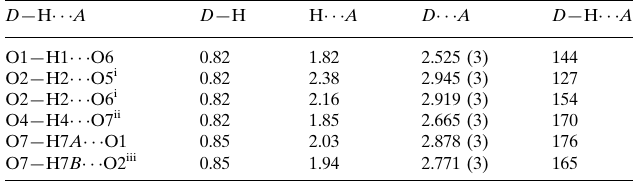
Hydrogen-bond geometry (A˚ , (cid:2)